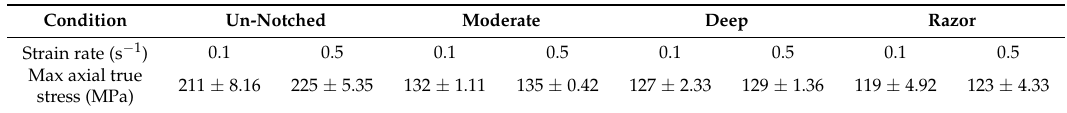
Table 1. Tensile properties of notched and un-notched polyetheretherketone (PEEK) specimens under different strain rates.